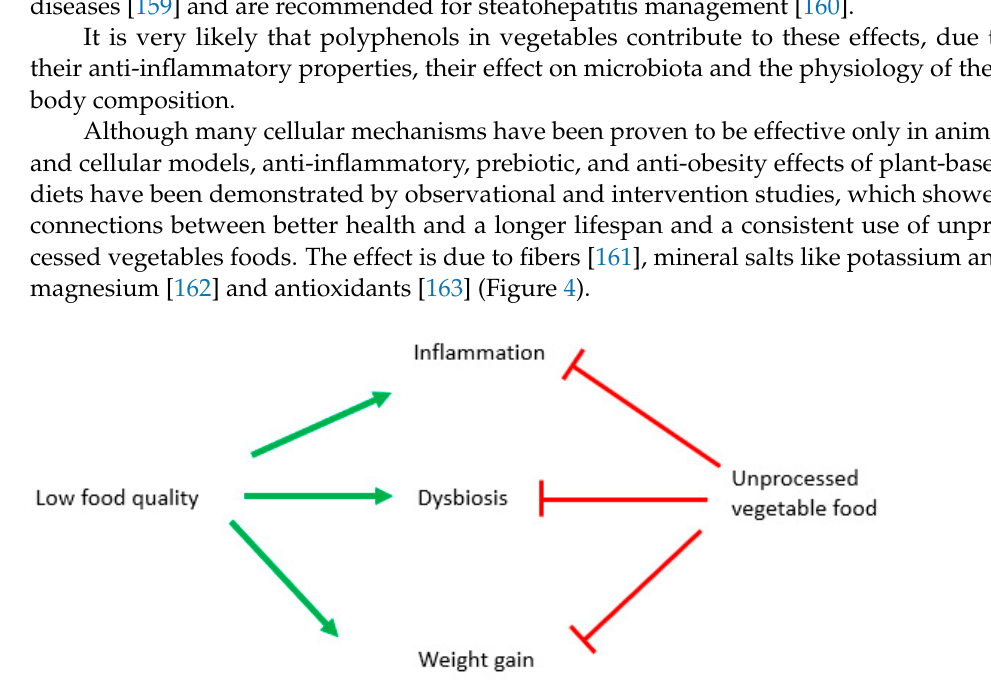
Figure 4. Potential role of diverse diet styles on inflammation, obesity and microbiota. Green arrows stimulate, and red lines block.